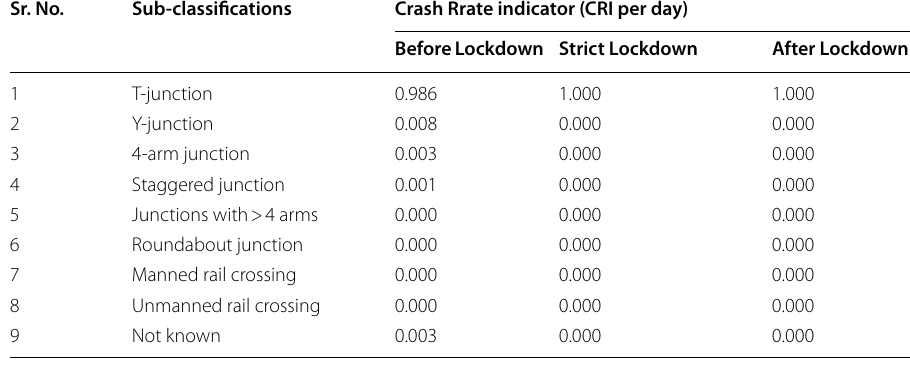
Table 8 CRI by intersection type and control Sr. No.